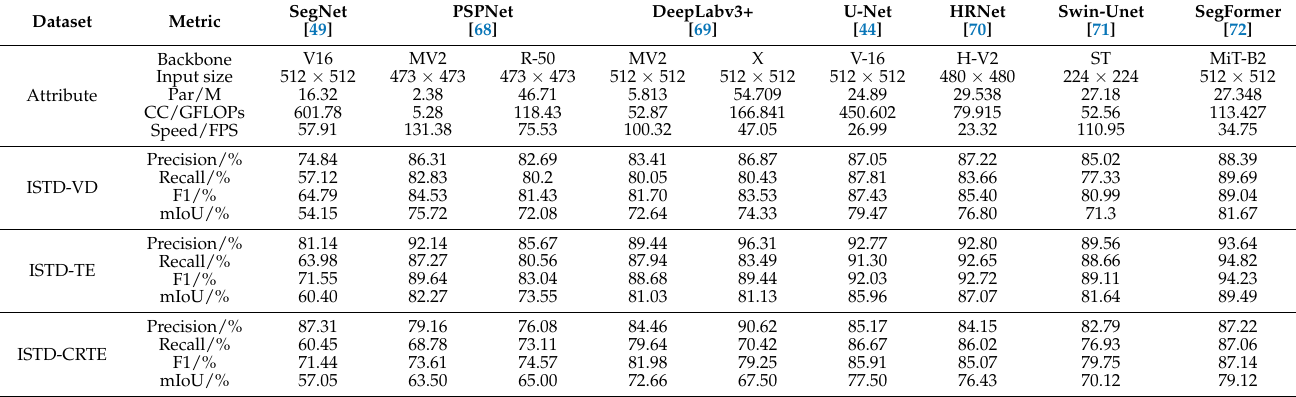
Table 4. Quantitative evaluation on the ISTD-PDS7 validation and test sets. V-16 = VGG16